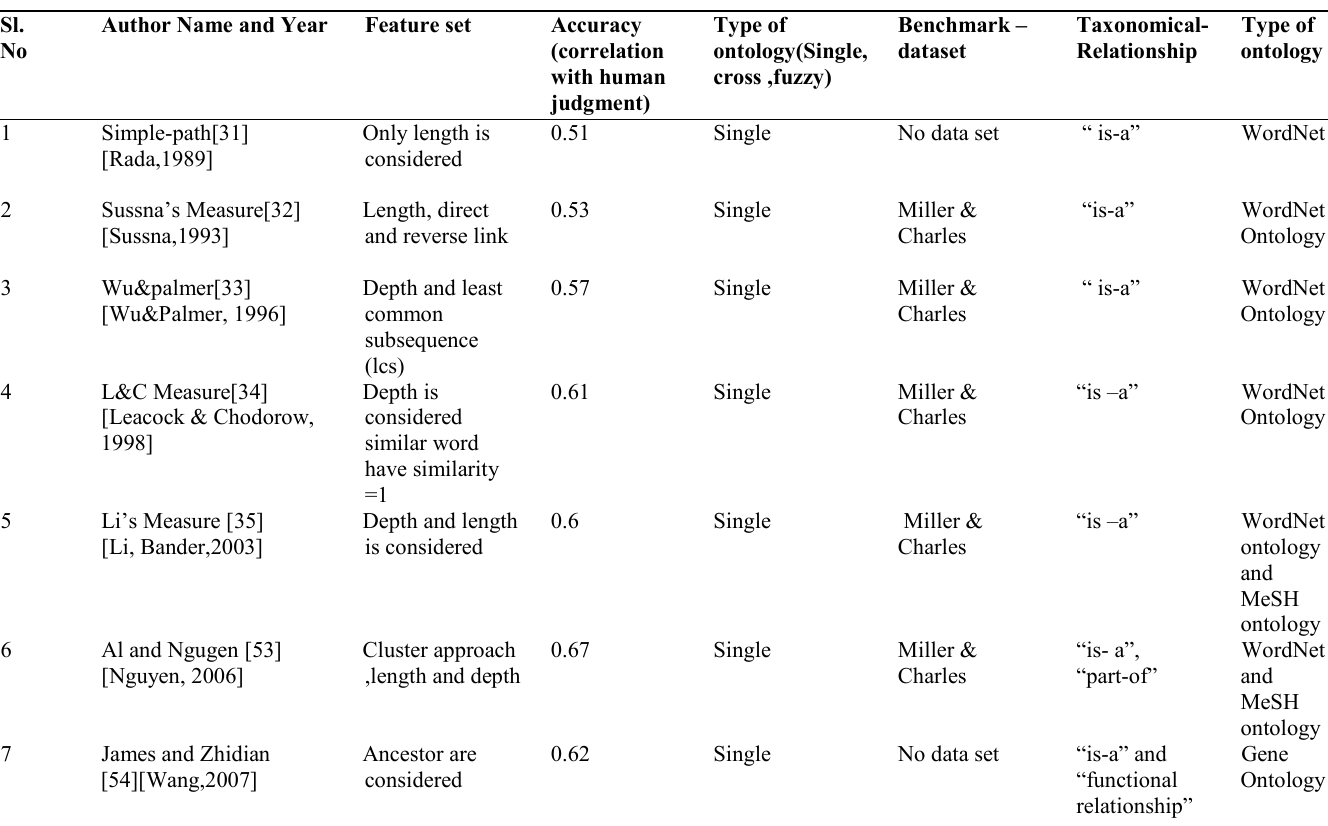
Table 2. Edge Based Measures on Various Parameter